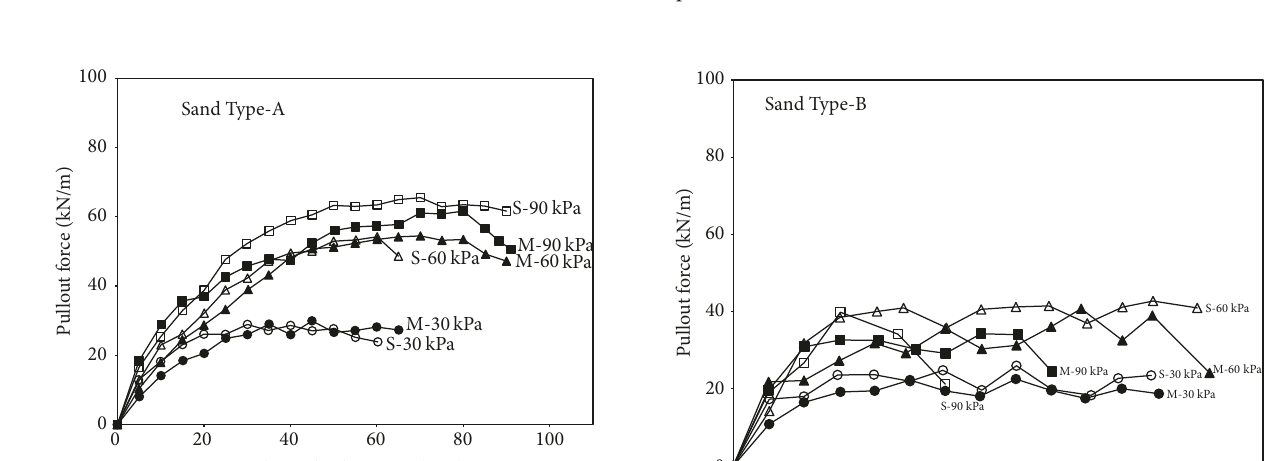
Figure 7: Schematics of the pullout test condition.